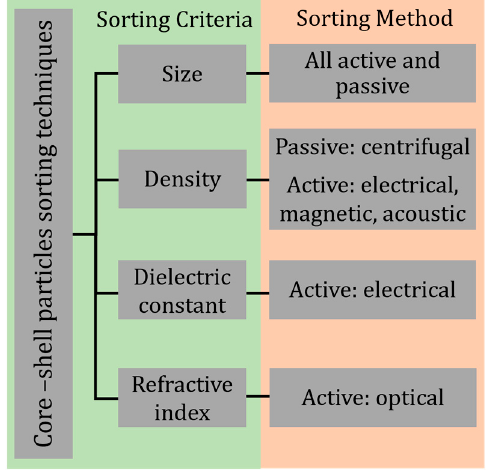
Figure 5. List of criteria and methods for sorting core–shell particles.